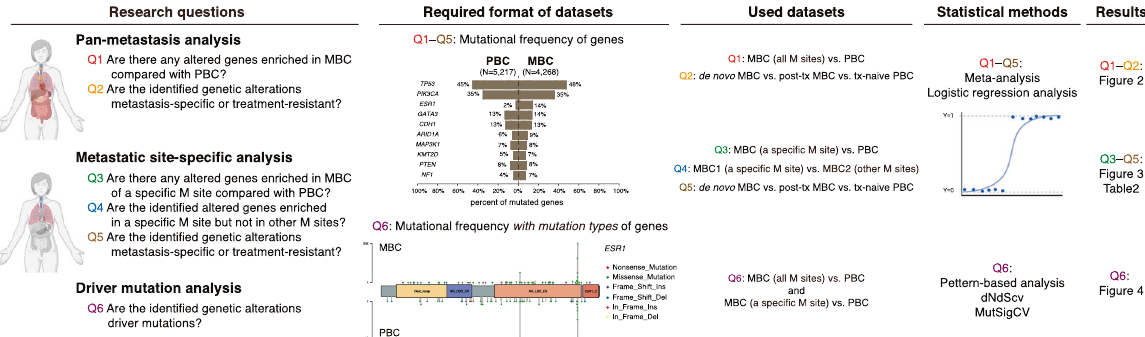
Fig. 1 The overall scheme of our study. This study aims to investigate the six research questions using three analyses including pan- metastasis analysis, metastatic site-speci fi c analysis, and driver mutation analysis. For each question, different datasets and data formats were used. Illustrations are created with Biorender.com and maftools 47